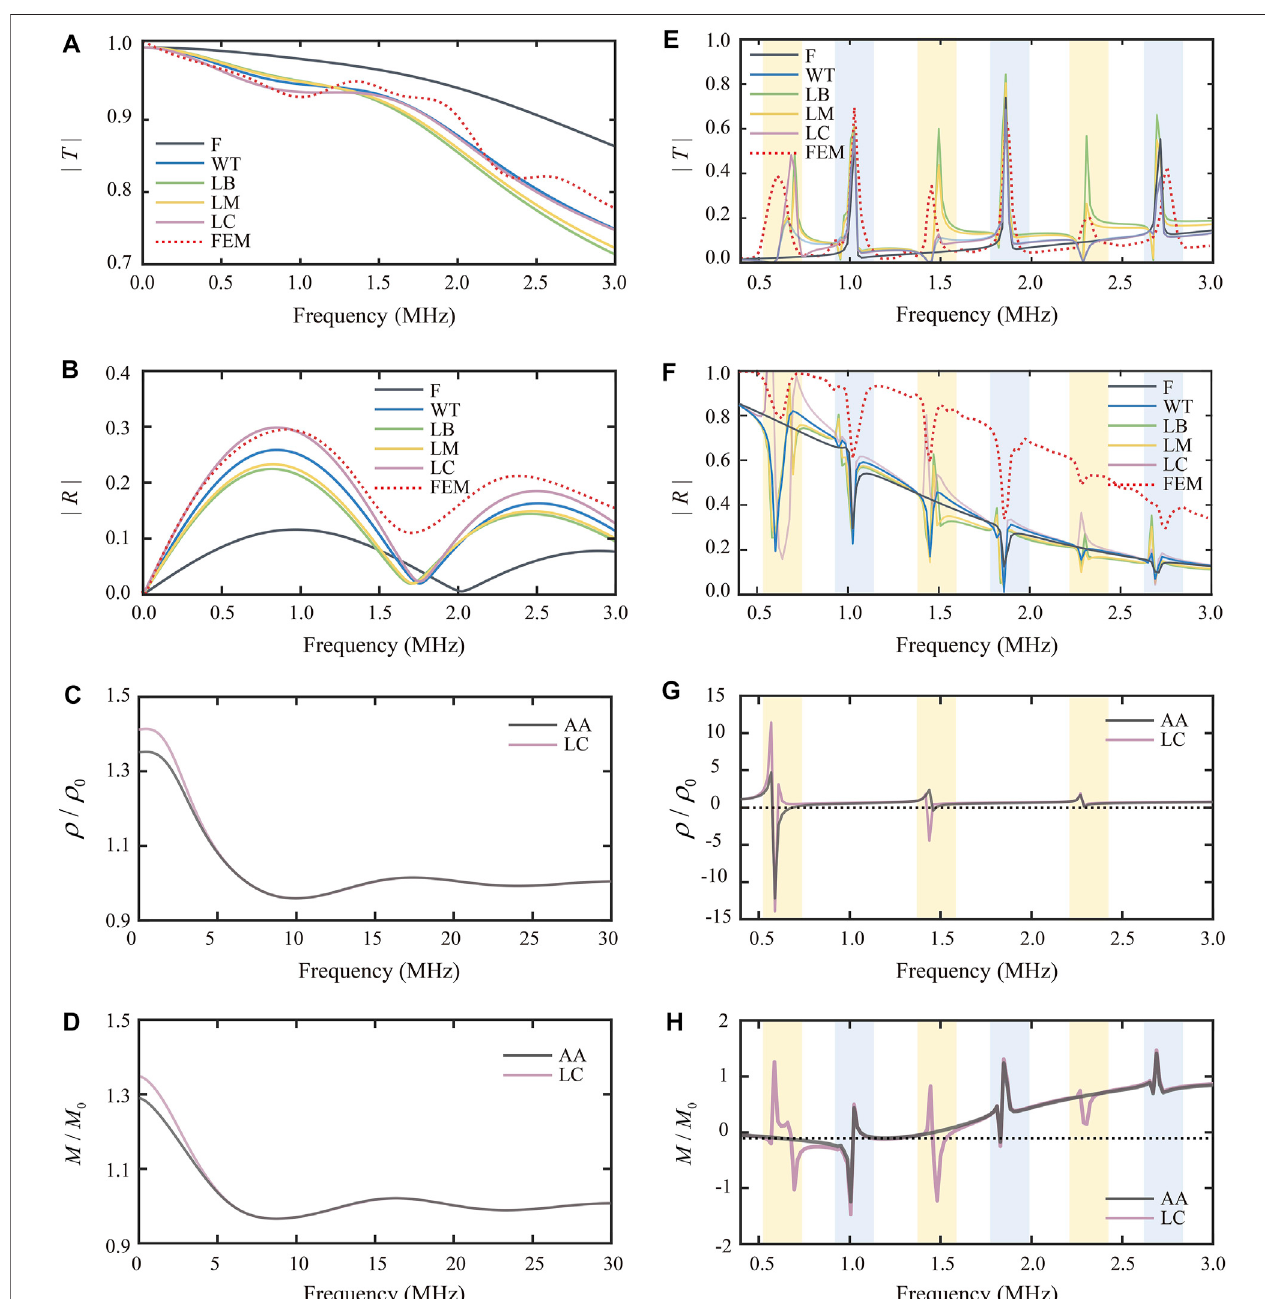
FIGURE2| Comparisonoftransmissionandre fl ectioncoef fi cientsmodulifordifferenttypesofscattererssuspendedinwaterbyMSTmodelsandFEMsimulations and calculation results of the real parts of the EMD and EBM corresponding to different type scatterers. (A) Modulus of the transmission coef fi cient versus frequency corresponding tosteel scatterers in water. (B) Modulus ofthe re fl ection coef fi cient versusfrequency corresponding tosteel scatterersin water. (C) Real part ofthe EMD versus frequency corresponding to steel scatterers in water. (D) Real part of the EBM versus frequency corresponding to steel scatterers in water. (E) Modulus of the transmission coef fi cient versus frequency corresponding to rubber scatterers in water. (F) Modulus of the re fl ection coef fi cient versus frequency corresponding to rubber scatterers in water. (G) Real part of the EMD versus frequency corresponding to rubber scatterers in water. (H) Real part of the EBM versus frequency corresponding to rubber scatterers in